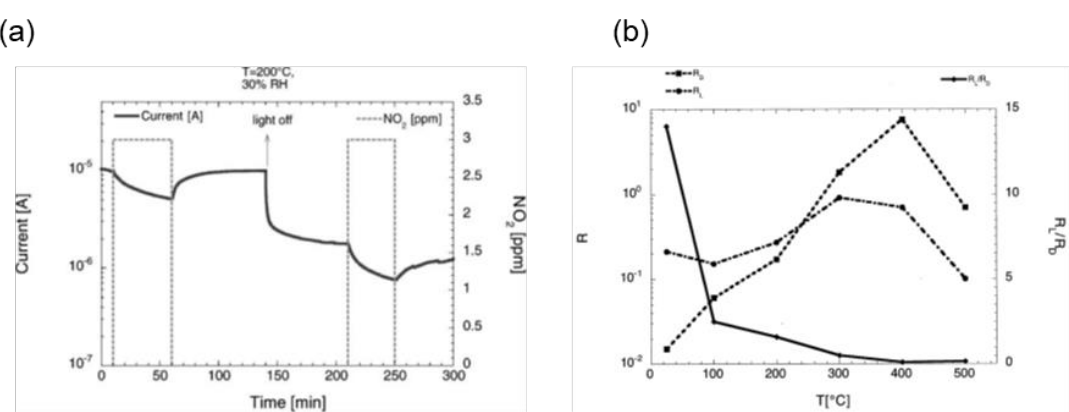
Figure 11. ( a ) Dynamic current measurements of the SnO 2 layer in presence of 3 ppm NO 2 , with and without UV exposure, at a working temperature of 200 ◦ C and 30% of relative humidity. Reproduced with permission [93]. ( b ) Response in dark- and UV-irradiation condition for the tin-oxide RGTO (rheotaxial growth thermal oxidation) samples gold-catalyzed as a function of the working temperature toward 100 ppm of CO at 30% of relative humidity. Reproduced with permission [94].